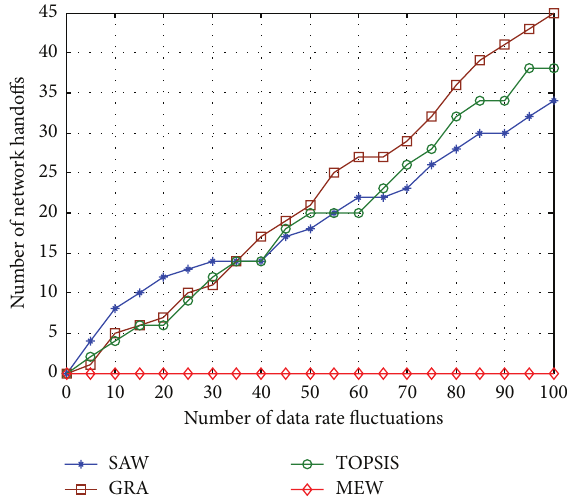
Figure 6: Network handoffs in case of weight 1.